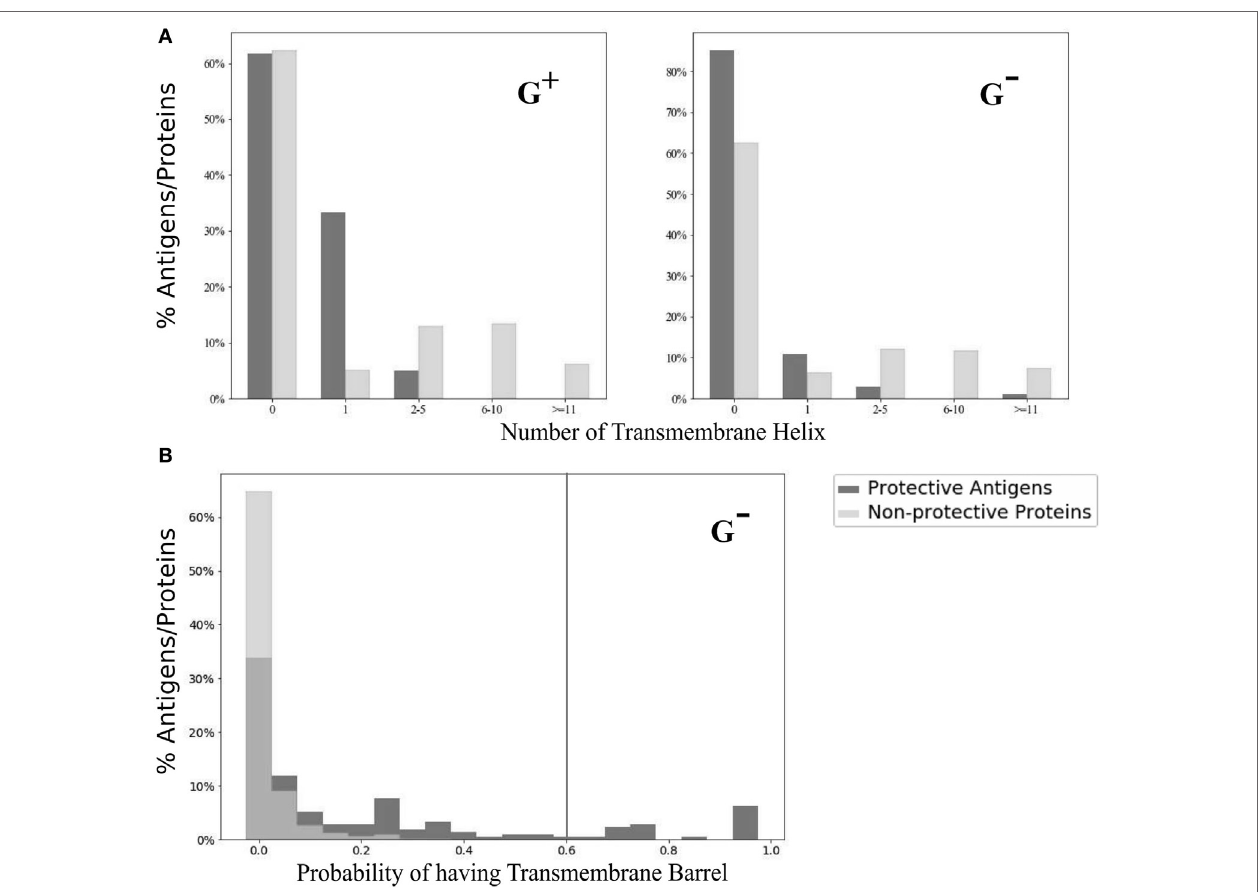
FigUre 3 | Transmembrane α -helix (G + and G − ) and β -barrel (G − only) profiles. As compared with non-protective proteins, there were much higher percentages of protective antigens with zero or one transmembrane α -helix (a) . For transmembrane β -barrel (B) , only two (0.0004%) out of all non-protective proteins had probability higher than the designated cutoff (indicated as black vertical line) described in